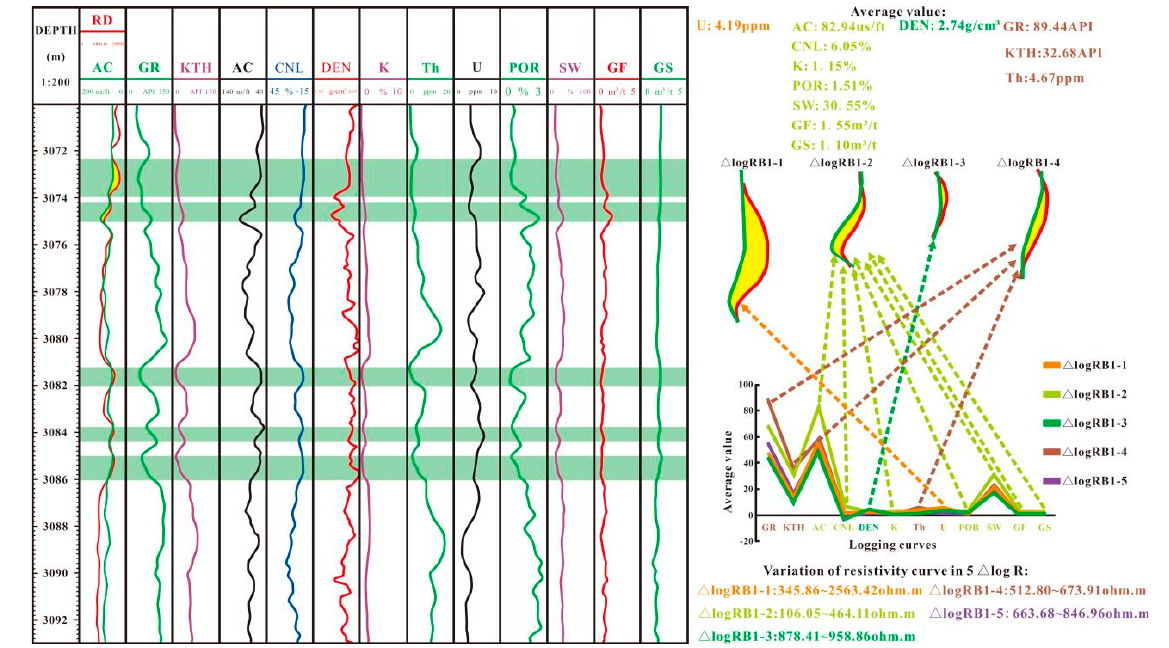
Figure 6. ∆ Log R of well B1 and the average of the corresponding reservoir parameters. Table 11. Actual logging data corresponding to ∆ logR1-1, ∆ logR1-2, ∆ logR1-3, and ∆ logR1-4 in B1 well. ∆ log RA1-1 ∆ log RA1-2